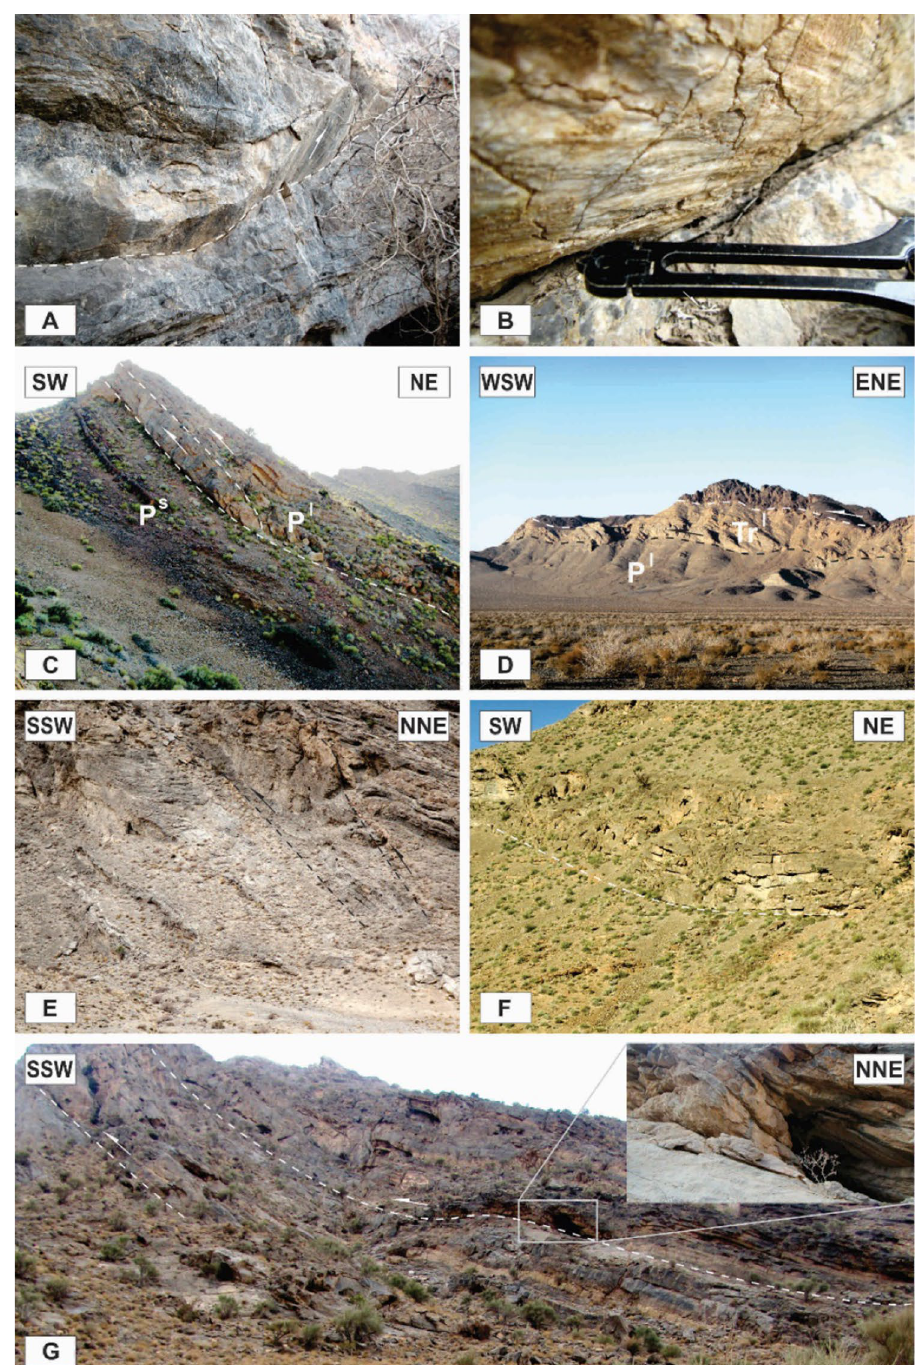
Figure 5. Some field photographs of two examples of faults’ planes and slickenlines ( A ,and B ), and the map- scale thrusts and reverse faults ( C – G ) of the study area. The compass needle is 55 mm long and toward N. (Photos are taken by Mohammad Ali